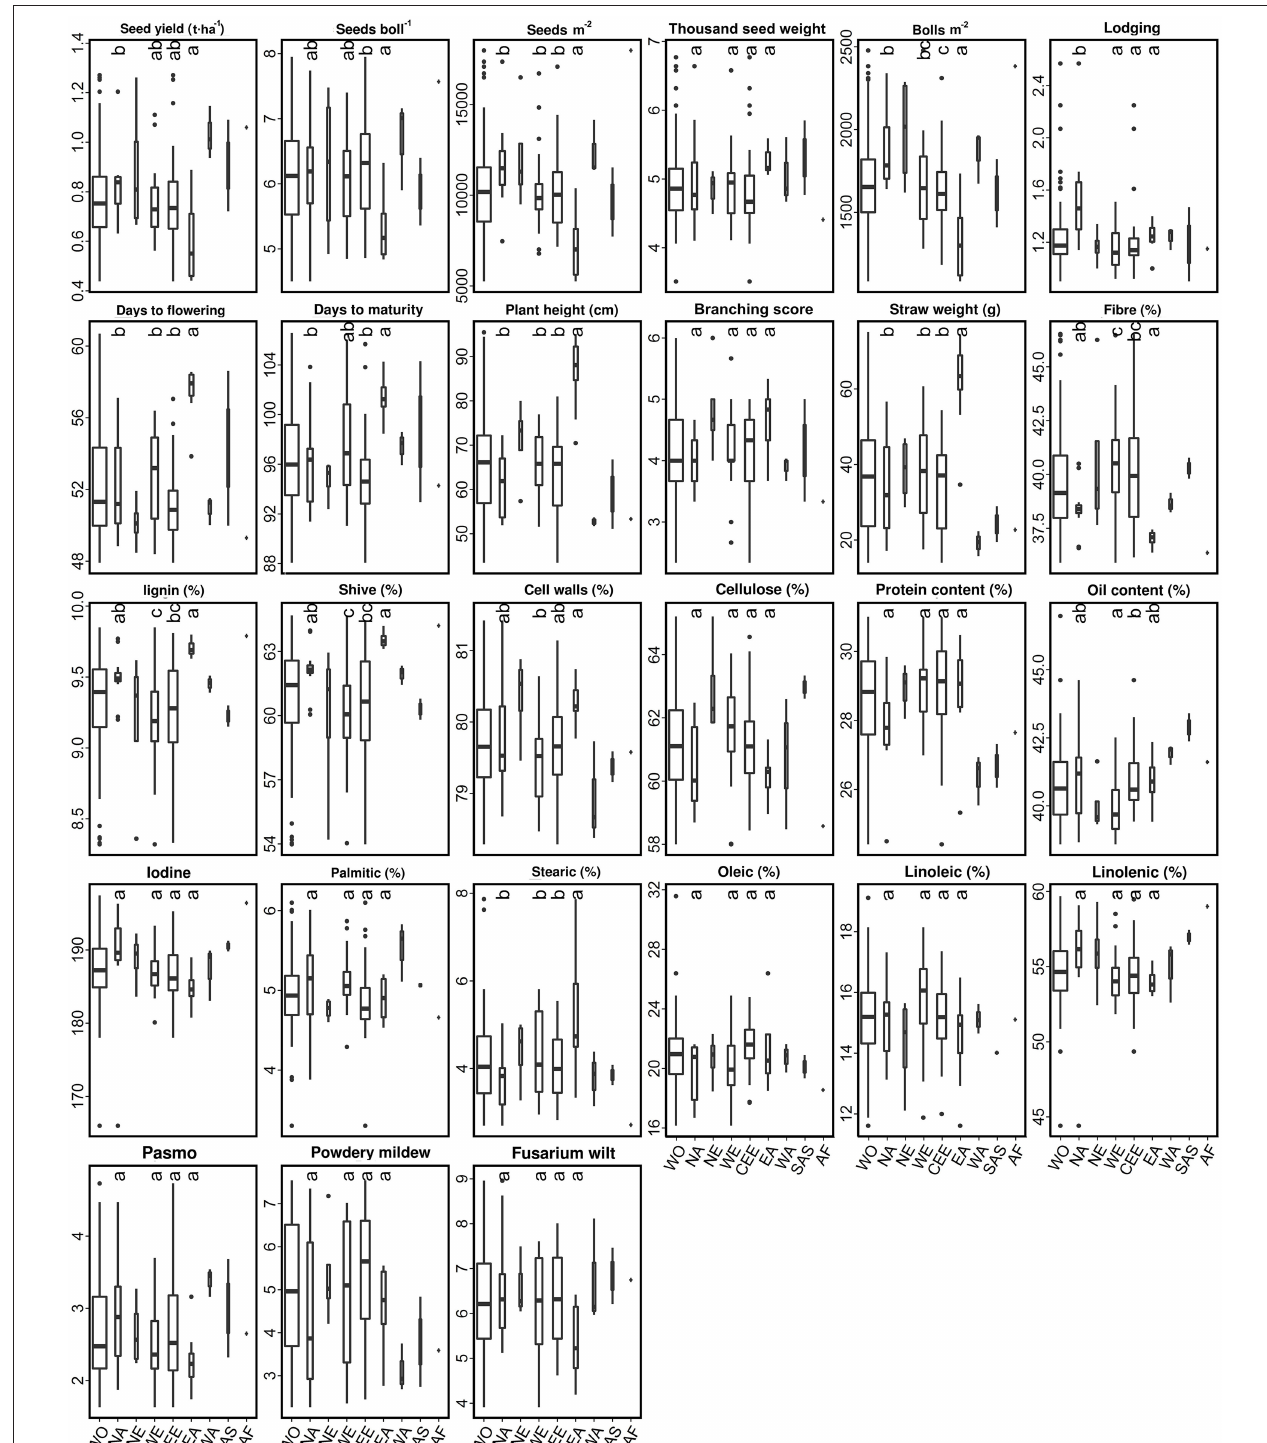
FIGURE 4 | Box plots of 27 traits of the 92 fiber accessions of the core collection in relation to their geographical origin. WO, the whole core collection; NA, North America; SA, South America; NE, Northern Europe; WE, Western Europe; CEE, Central and Eastern Europe; SE, Southern Europe; EA, Eastern Asia; WA, Western Asia; SAS, Southern Asia; OC, Oceania; AF, Africa. Traits are indicated above each graph. Different letters at the top of each boxplot represent statistical significance at the 5% probability level among the four geographical regions with five or more accessions. Box widths are proportional to the sample size of the subsets.